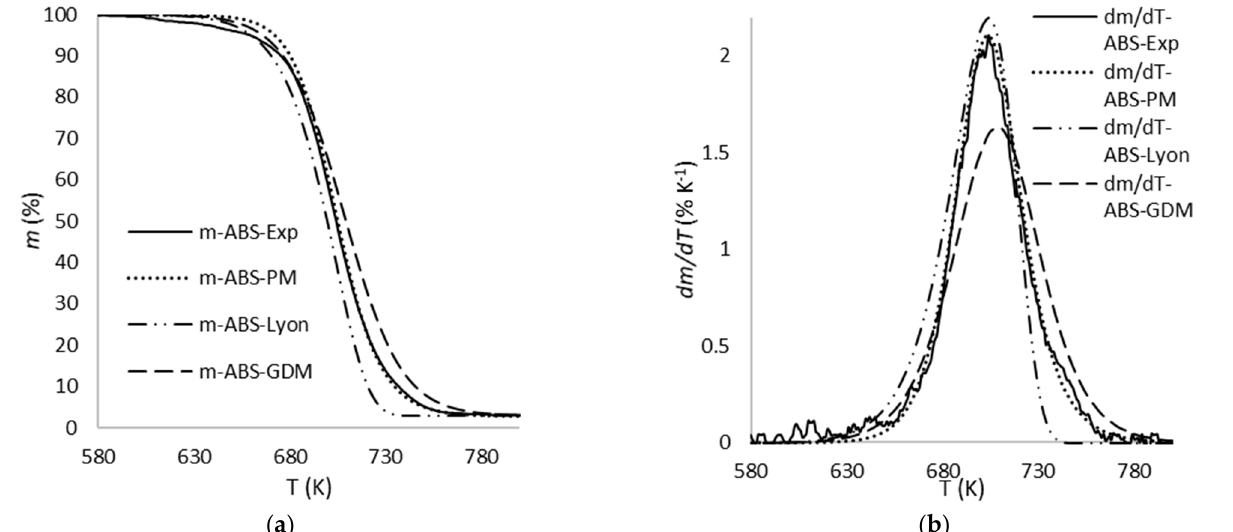
Figure 11. A comparison of experimental and calculated ( a ) mass and ( b ) dm / dT results for ABS.